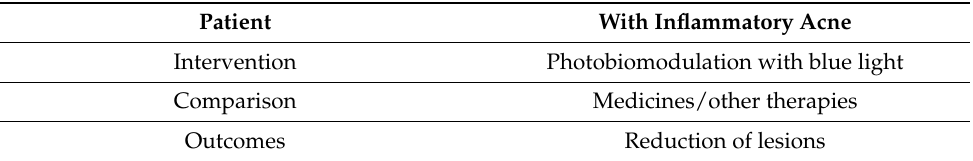
Table 1. PICO—Patient, Intervention, Comparison and